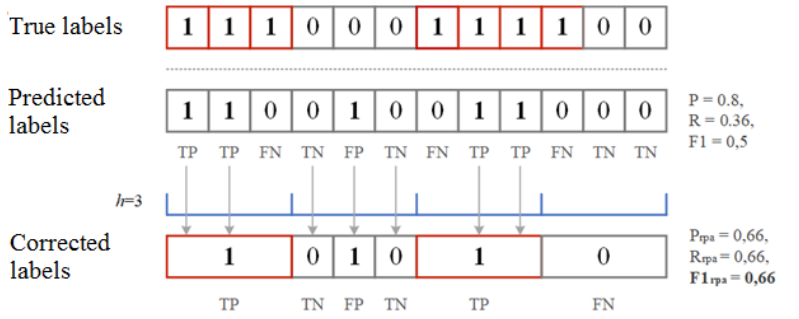
Figure 5. True, predicted, and corrected labels in case of the RPA approach to the metrics calculation. Another metric is the composite F 1 score [50]. For this metric, precision is considered as P (by the number of points), and recall is calculated as R rpa (by the number of segments): P × R rpa F 1 c = 2 × . P + R rpa